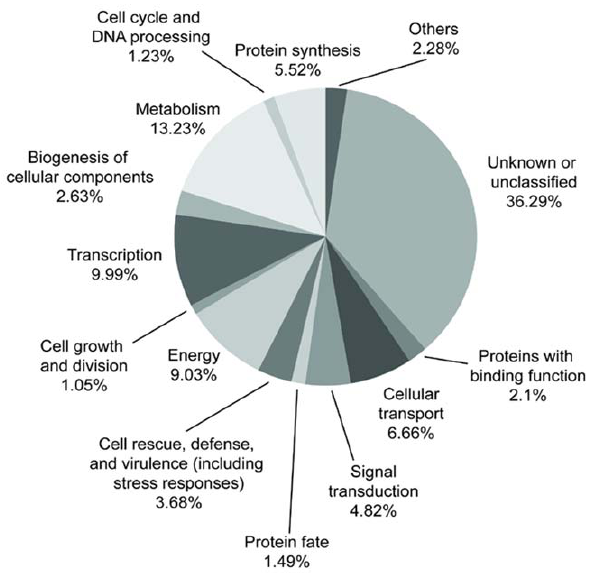
Figure 1. Functional classification of unique S.chinensis ESTs according to the MIPS Functional Catalogue scheme.